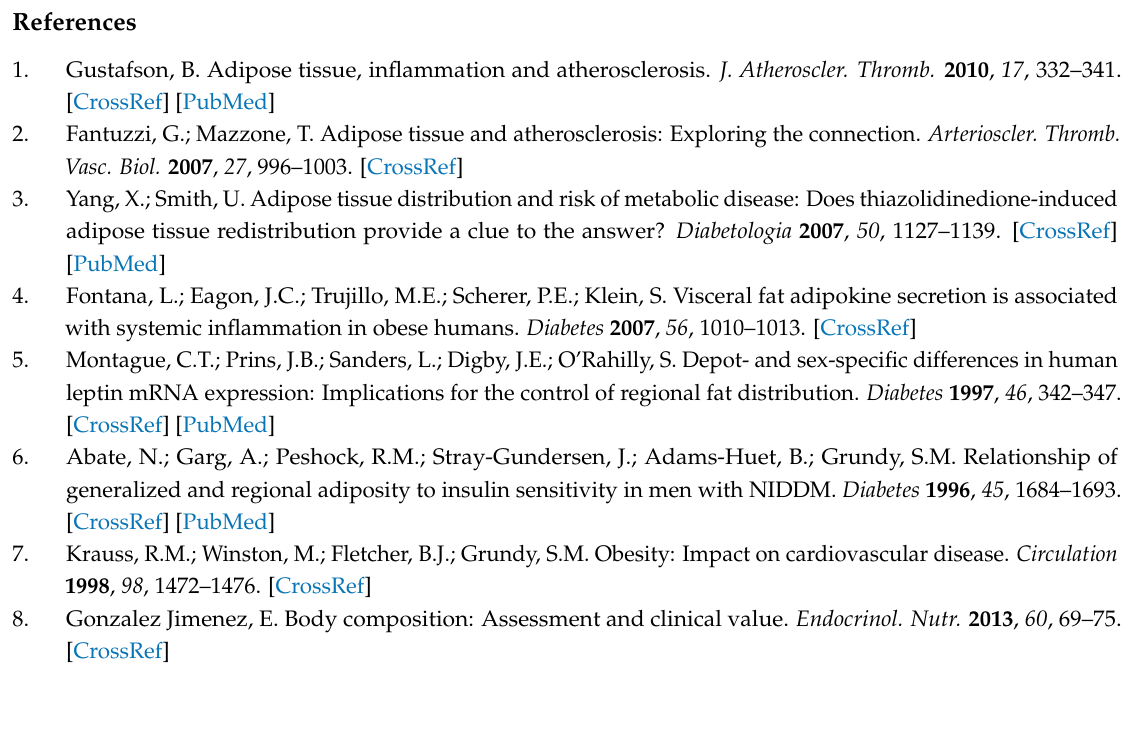
associations of diastolic blood pressure with all risk factors (1760 participants without anti-hypertensive medication, aged 20 to 94 years old, examined in 2015), Table S4: associations of hypertension with all risk factors (2336 participants without anti-hypertensive medication, aged 20 to 94 years old, examined in 2015), Table S5: crude and adjusted associations of blood pressure with per SD increase of skinfold thickness in men of different age subgroups (554 participants without anti-hypertensive medication, aged 20 to 94 years old, examined in 2015), Table S6: crude and adjusted associations of blood pressure with per SD increase of skinfold thickness in women of different age subgroups (1206 participants without anti-hypertensive medication, aged 20 to 94 years old, examined in 2015), Table S7: crude and adjusted associations of hypertension with per SD increase of skinfold thickness in men of different age subgroups (767 participants, aged 20 to 94 years old, examined in 2015), Table S8: crude and adjusted associations of hypertension with per SD increase of skinfold thickness in men of different age subgroups (1569 participants, aged 20 to 94 years old, examined in 2015), Table S9: blood pressure and hypertension in different skinfold thickness stratified groups (2336 Participants, aged 20 to 94 years old, examined in